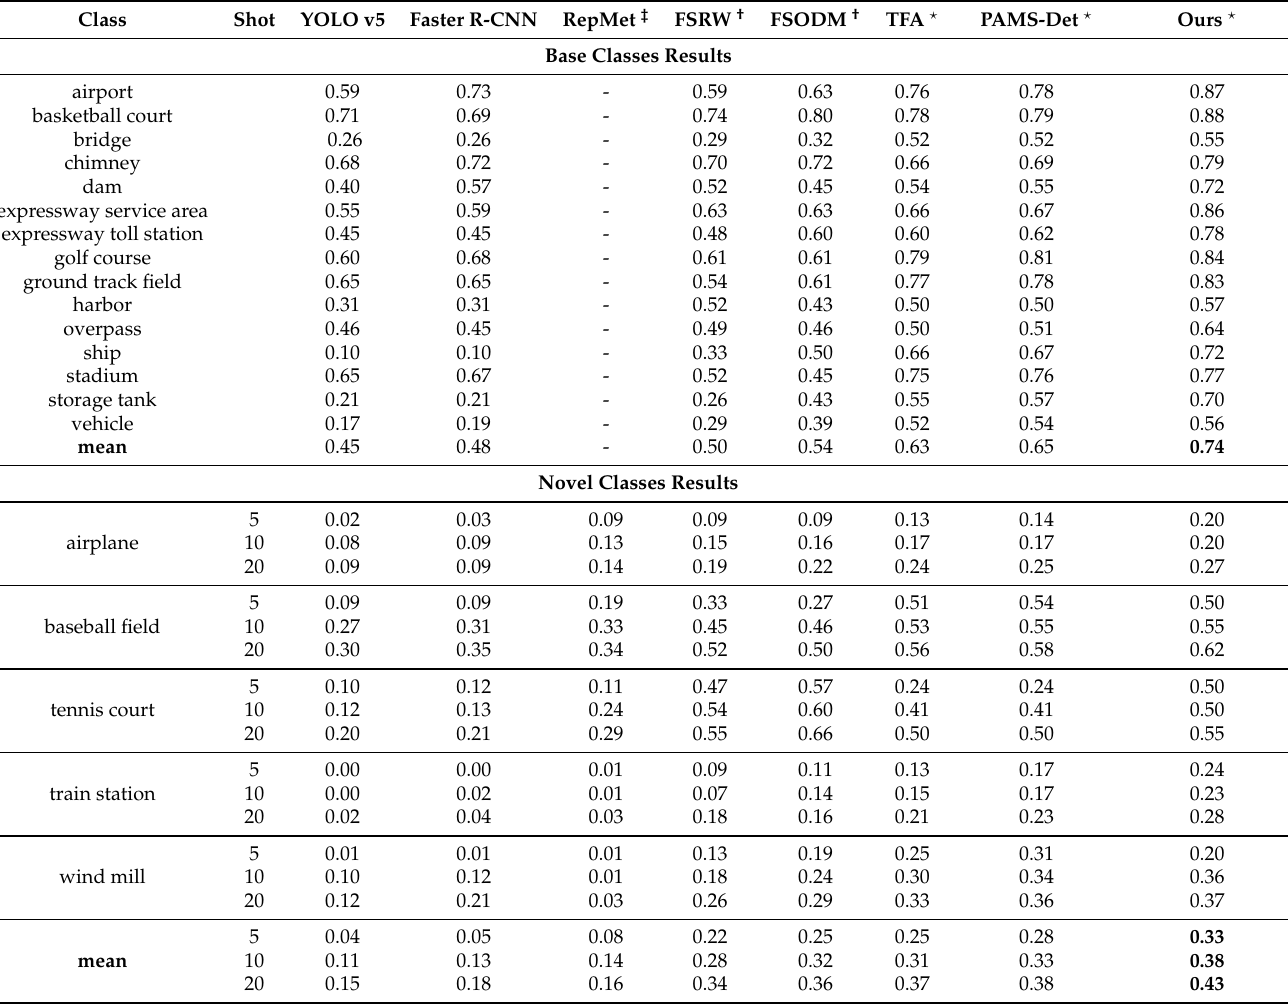
Table 3. Comparison of the base and novel classes results on the DIOR